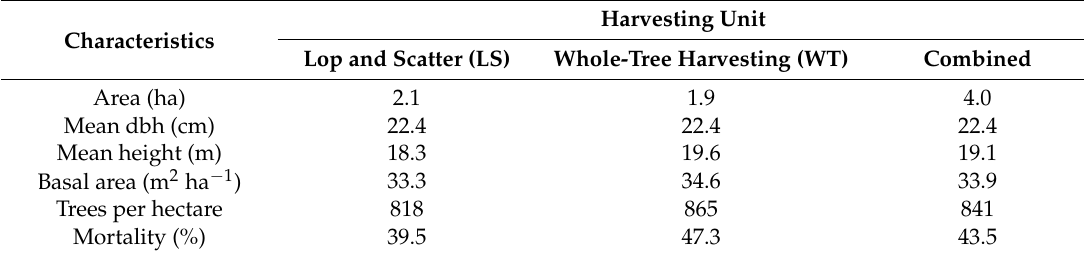
Figure 1. Site map of the study harvest unit located in the Colorado State Forest State Park. Table 1. Stand characteristics of the study harvest unit.